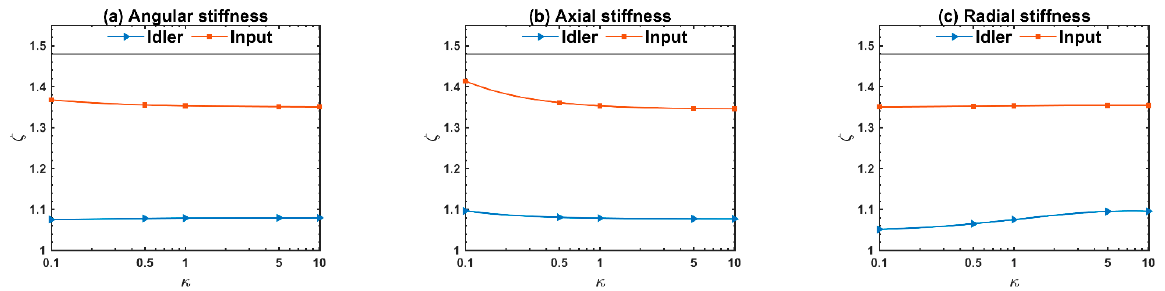
Figure 15. Diagram of the mounting error of a face gear. Figure 14. Influence of the angular, axial, and radial stiffness of the lower face gear on the load sharing.